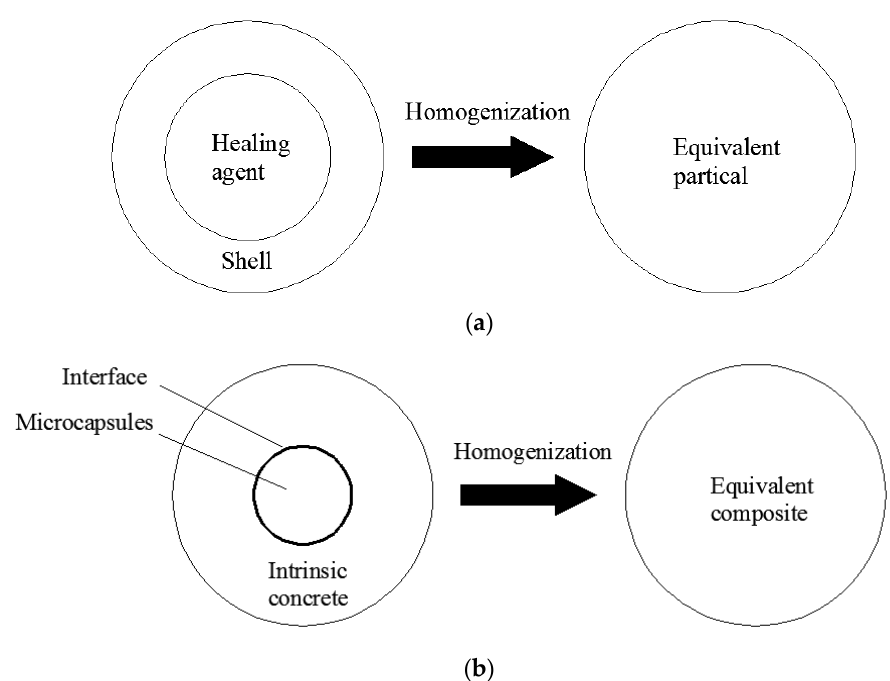
Figure 2. The homogenization process: ( a ) the first level: the homogenization of the shell and healing agents inside, and ( b ) the second level: the homogenization of the intrinsic concrete, the equivalent inclusion and interfaces.